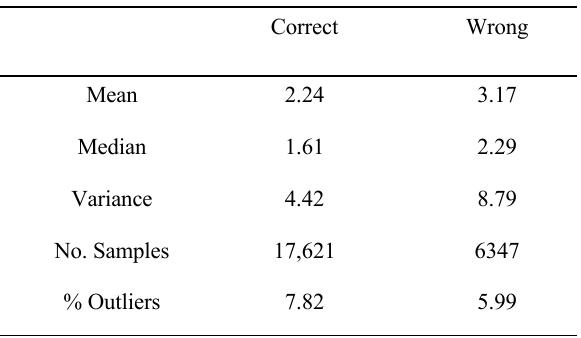
Table 1: Statistics from the singleton search experiment.